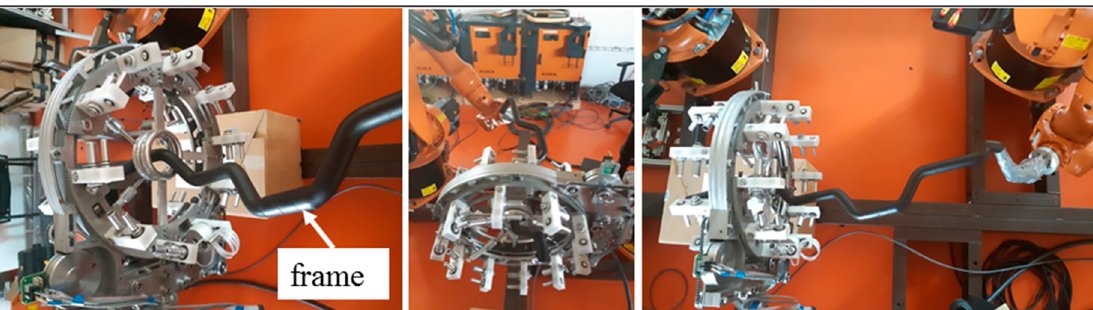
Figure 22. Test 2—Frame passage testing through fiber-processing head for calculated optimal REE trajectory.